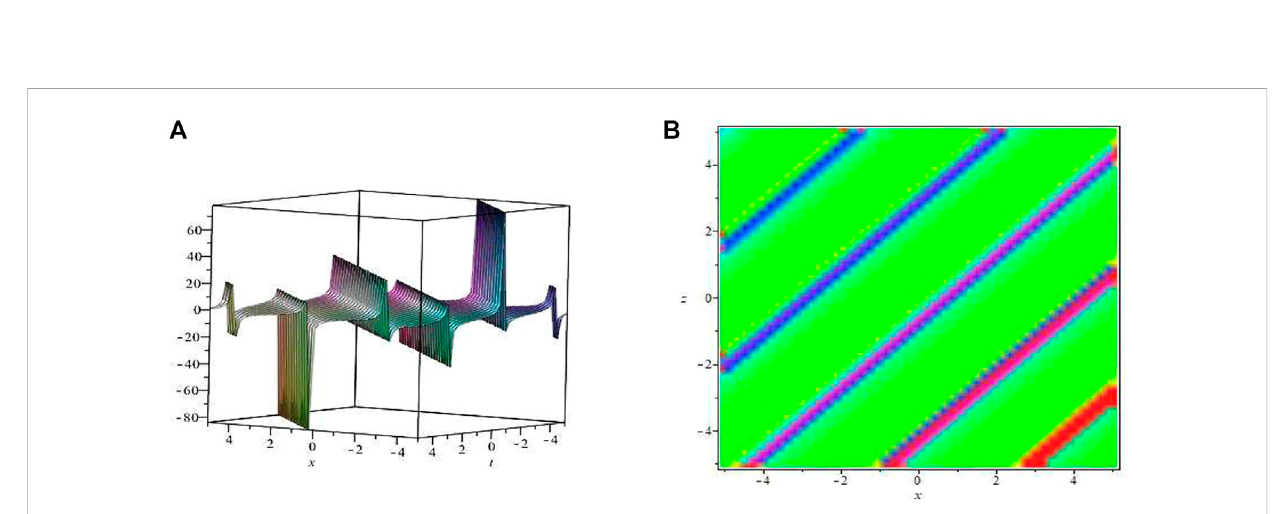
FIGURE 3 Multi period solution of